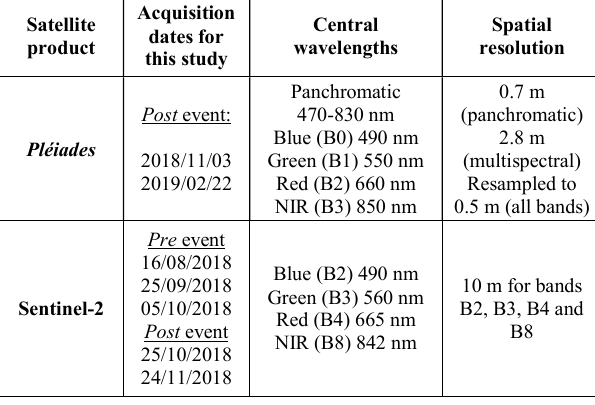
Table 1 . Imaging capabilities of Pléiades and Sentinel-2 instruments in the visible and near infrared bands